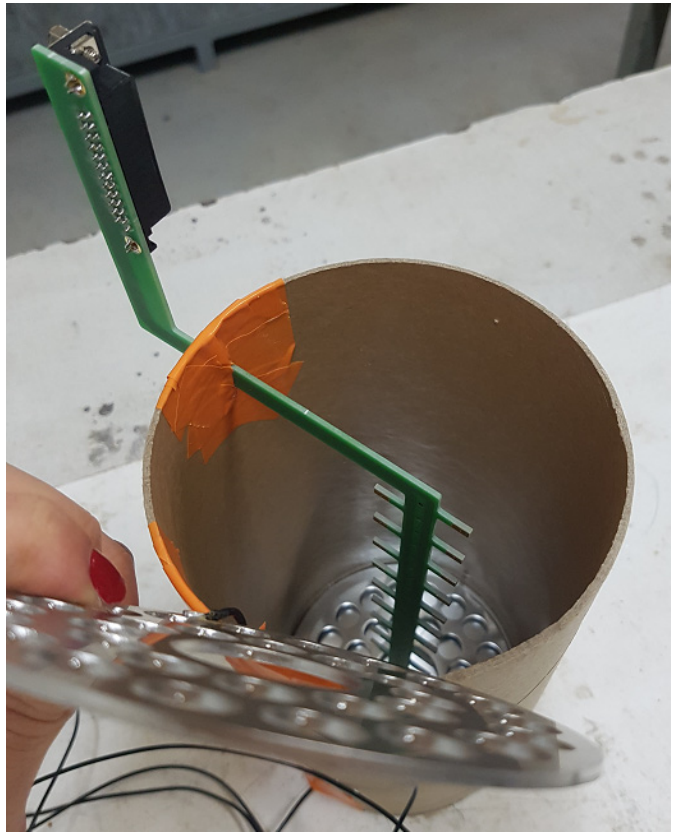
Figure 2. View of a PCB sensor placed on the axis of a cylindrical mold designed to cast the concrete specimen.